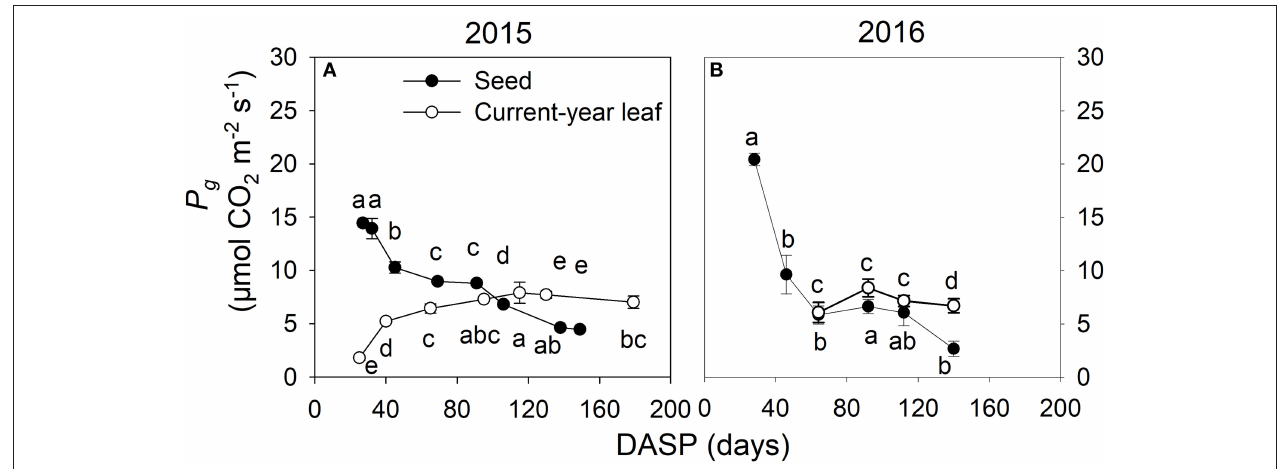
FIGURE 8 | Gross photosynthetic rate (mean ± SD) in seeds (filled circles) and leaves (open circles) of Torreya grandis cv. “Merrillii” during growing season 2015 under PAR = 800 µ mol m − 2 s − 1 (A) and during growing season 2016 under PAR = 1,300 µ mol m − 2 s − 1 (B) . n = 4 trees. DASP, days after seed protrusion. Different letters denote significant differences in seeds during the seed development stages (up of the line and scatter plot), and in current-year leaves during the seed development stages (down of the line and scatter plot) at P ≤ 0.05 level.